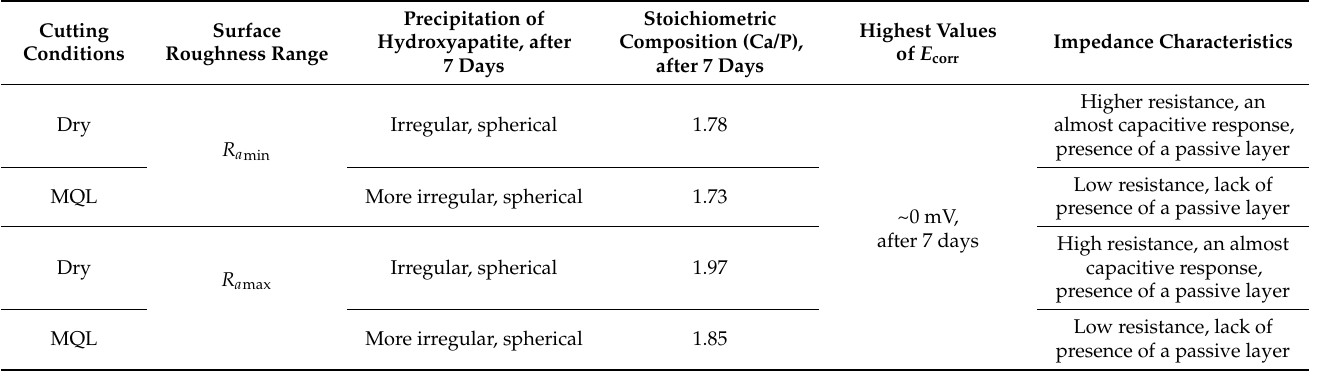
Table 4. Summary of Corrosion Resistance and Surface Bioactivity Results of Samples with R a min and R a max of Ti6Al4V Alloy after Turning under Ecological Cutting